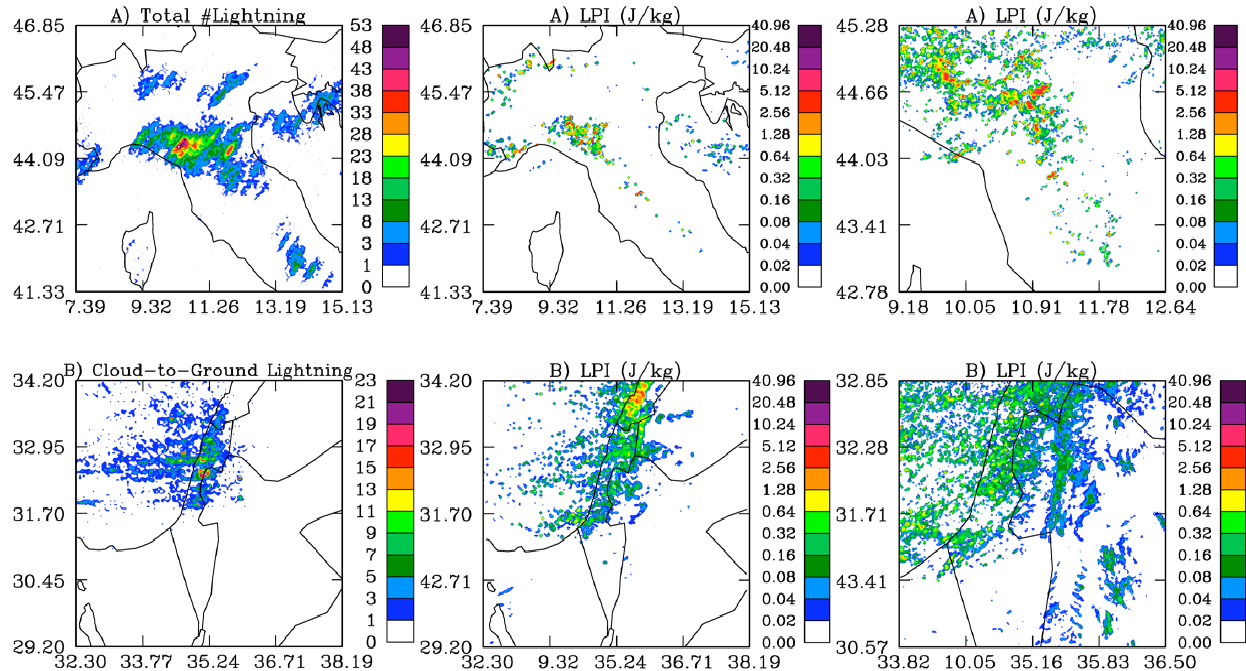
Fig. 1. Observed 24h lightning is two case studies for Italy and Israel. The upper row is for case study (A) 9 September 2008 (ZEUS network), and the lower row for case study (B) 28 February 2009 (LPATS network), respectively. WRF model calculated, 24h averaged, Lightning Potential Index (LPI) for both cases at 4km (center) and 1.33km (right) grid resolution for the same dates.